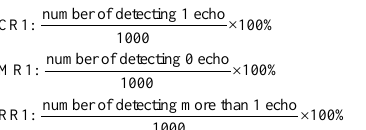
Figure 3. An example of a simulated waveform